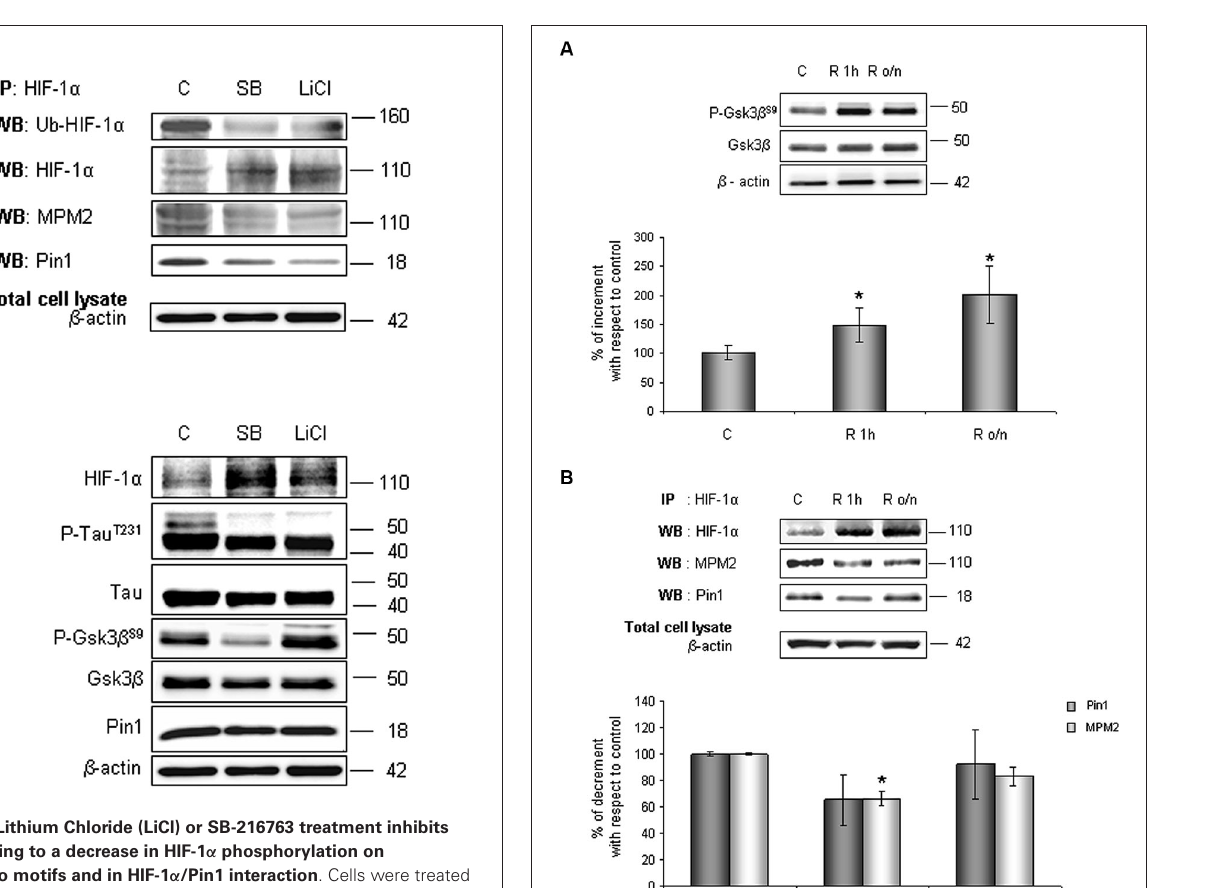
we had already established that juglone-mediated Pin1 inhibition leads to Tau T231 phosphorylation increase (Bulbarelli et al.,